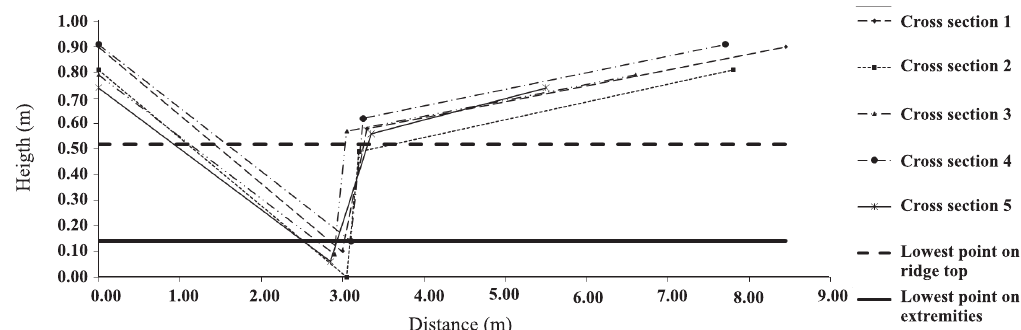
figure 7. original cross section profile of the channel of terrace